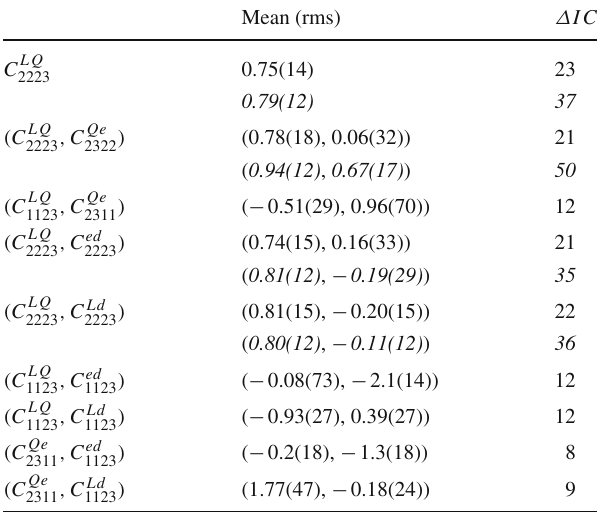
Table 2 Values of the SMEFT WCs fit from data in all the considered scenarios along with relative Δ IC . The italic values highlight the